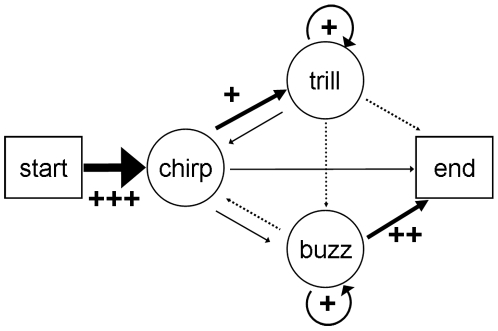
Model of song based on transition frequencies.Arrows represent transitions from one phrase to the next. Plus (+) symbols represent transitions that deviated from expected more than 10% (+), 20 % (++) or 50% (+++). Arrow thickness increases with transition frequencies based on values in Figure 5. No arrows were drawn for frequencies less than 0.05. See Figure 1 and Figure 2 for examples of each phrase.